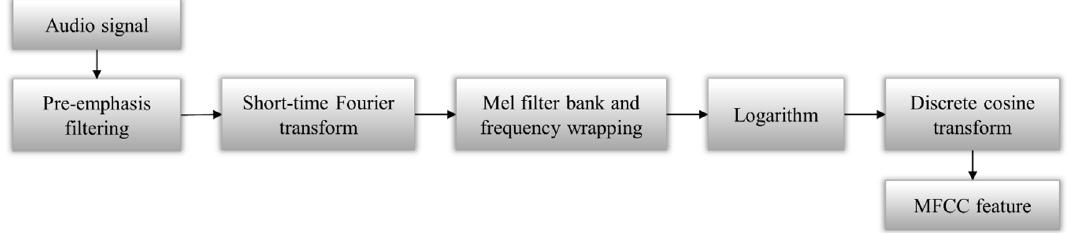
Figure 2. MFCC extraction procedure [17].